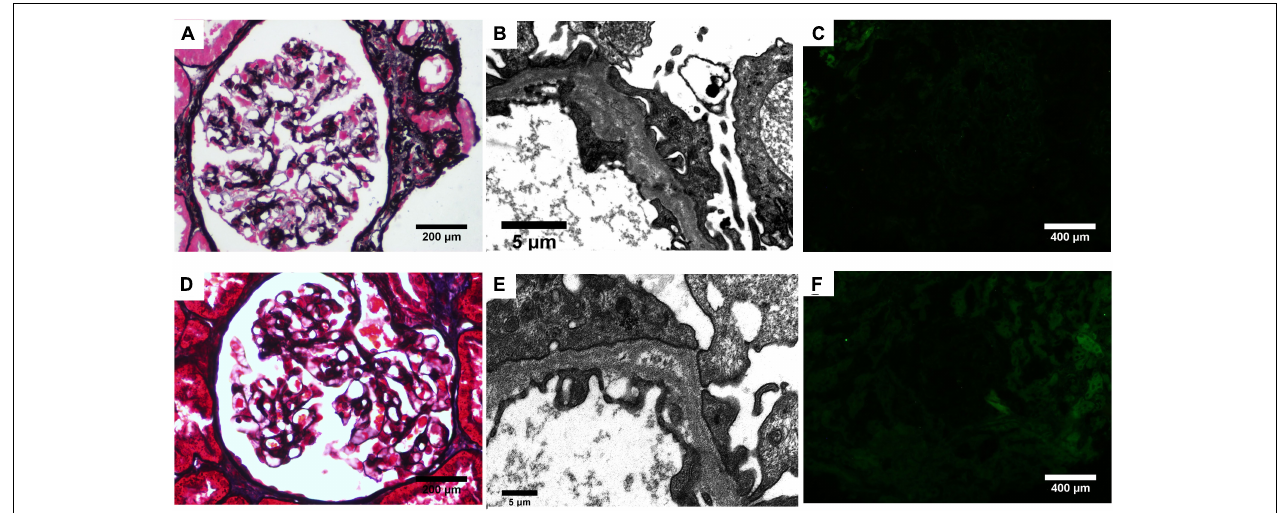
FIGURE 1 | Renal biopsy findings. (A–C) Biopsy from the proband. (A) Mild mesangial cells and matrix proliferation is seen (PASM). (B) Lamina densa lamellation and splitting is seen along the GBM on electron microscopy. (C) Complete absence of α 5 staining in the glomerular and tubular basement membranes. (D–F) Biopsy from the elder sister. (D) Segmental mesangial cells and matrix proliferation is seen (PASM). (E) Electron microscopy revealed splitting GBM. (F) The α 5 staining in the glomerular and tubular basement membranes was absent.